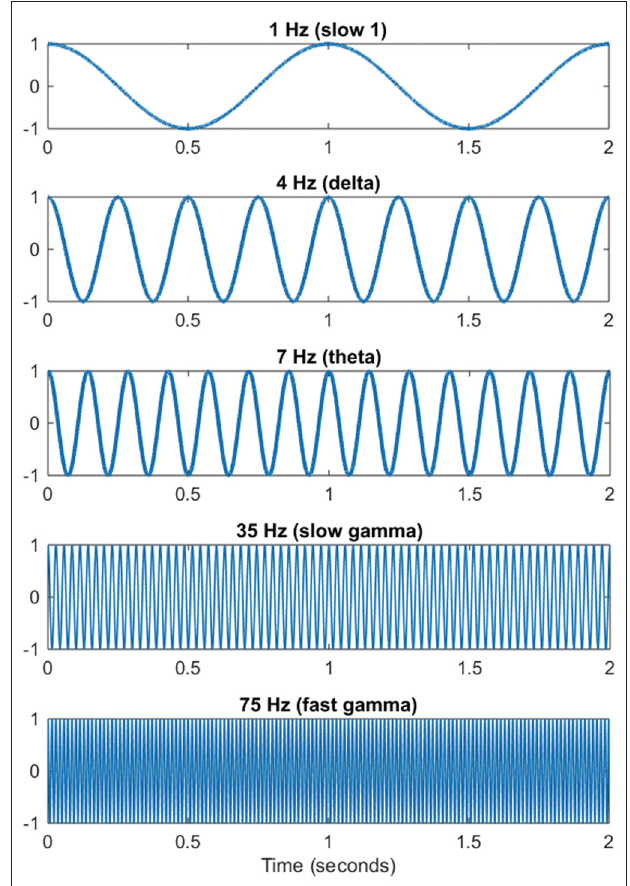
FIGURE 2 | Oscillations of varying frequency. MATLAB generated sine curves to represent neuronal oscillations that make up the unfiltered electroencephalogram (EEG). Each panel represents a distinct frequency and in parentheses the corresponding oscillatory band name most often associated with